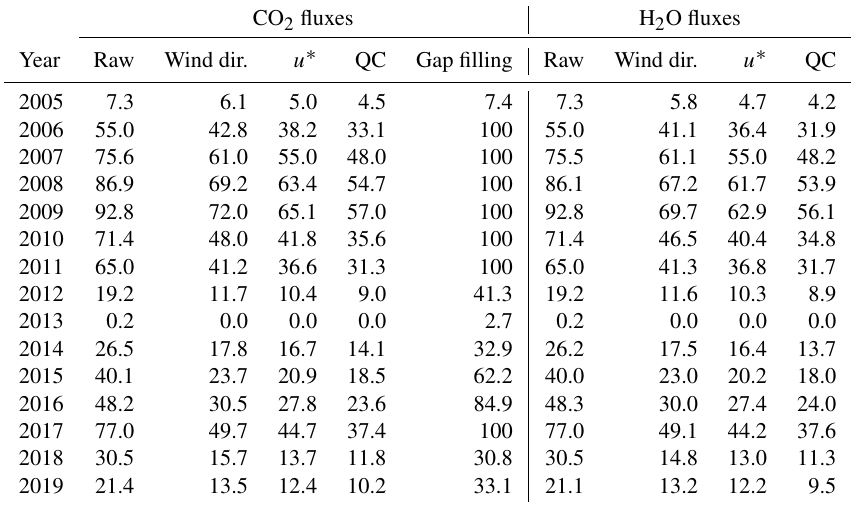
Table A1. Data availability after individual processing and filtering steps (all units in percent of the whole year). CO 2